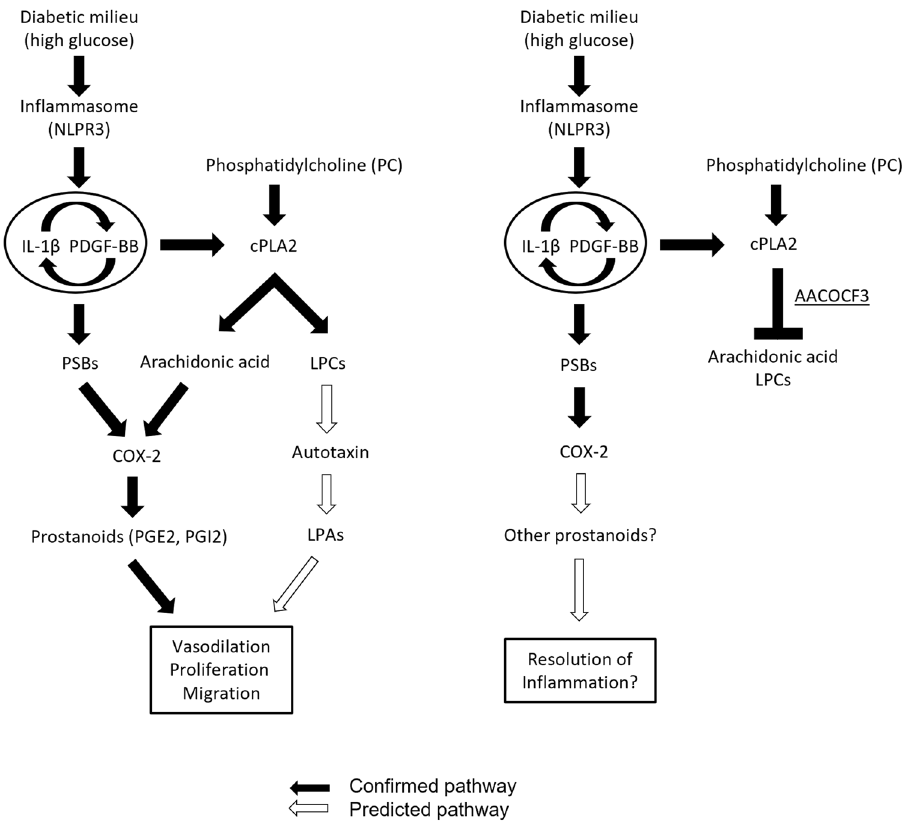
Figure 8. Signaling pathway overview. Hyperglycemia stimulates mesangial production of IL-1β which activates PDGF-BB secretion. In turn, PDGF-BB promotes IL-1β secretion, sustaining and boosting the pathway activation. IL-1β and PDGF-BB stimulation give rise to the production of phosphorylated sphingoid bases, activating COX-2 transcription. At the same time, IL-1β and PDGF-BB stimulate cPLA2 activation. Arachidonic acid (AA) released by cPLA2 is converted into prostanoids by COX-2 and downstream enzymes. The other product of cPLA2, lysophosphatidylcholine (LPC), is converted into lysophosphatidic acid (LPA) by autotaxin. Thus, hyperglycemia triggered the activation of an interplay between IL-1β and PDGF-BB which stimulates the secretion of lipid hormones (prostanoids PGE2, PGI2, but also lysophosphatidic acid) with hemodynamic, proliferative, and migratory effects at glomerular level. Inhibition of the cPLA2 reaction with AACOCF3 blocks the supply of AA for the COX-2 reaction, thus resolving the inflammatory stimulus. In addition, LPC is not produced, and this blocks the supply for the autotaxin reaction and LPA mediated proliferative